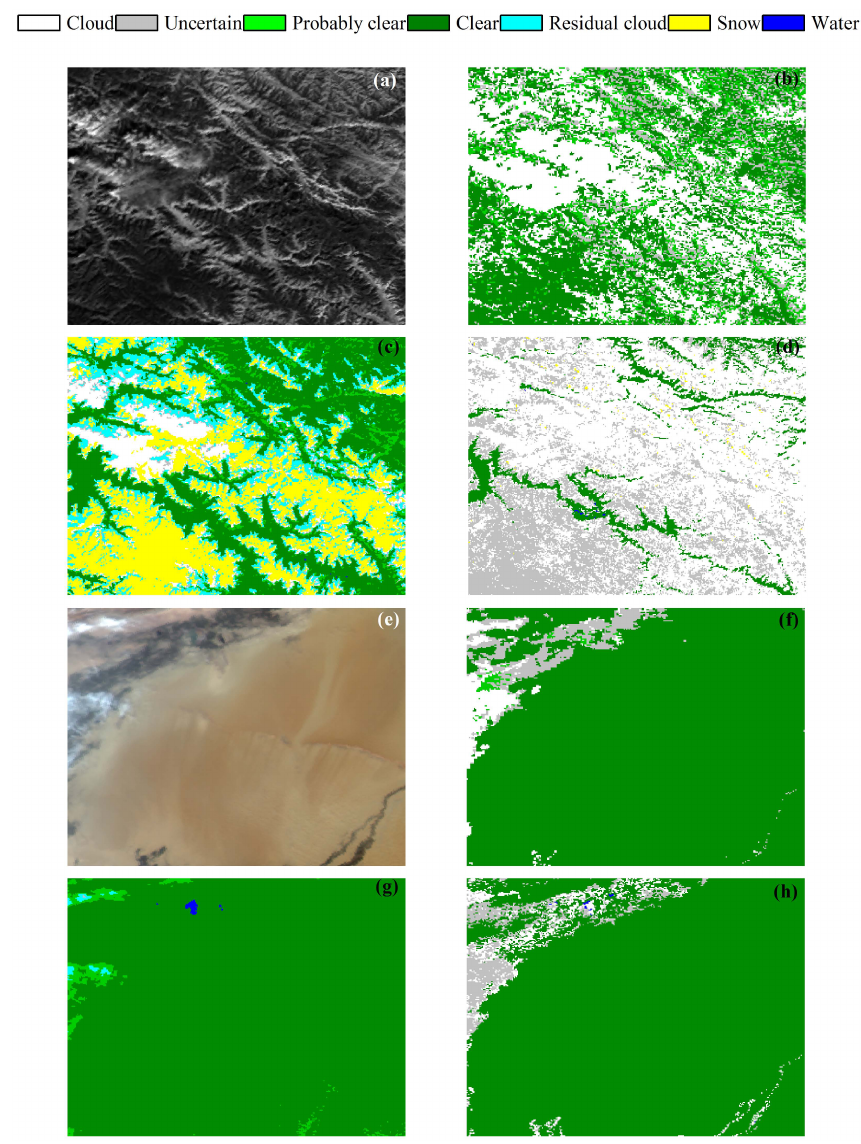
Fig. 8. Two cases during the seasons with poor HR scores compared with MODIS. (a) – (d) The snow-covered case on 12 December 2011 (VIRR at 05:25:00UTC, MODIS at 05:20:00UTC). (a) The VIRR gray-scale image of channel 6 (1.55–1.64µm); (b) – (d) the cloud detection results from MODIS, the proposed algorithm, and the official VIRR product, respectively. (e) – (h) The case over deserts on 24 August 2011 (VIRR at 05:00:00UTC, MODIS at 05:05:00UTC). (e) The true-color VIRR image composed of channel 1 (red), channel 9 (green), and channel 7 (blue); (f) – (h) the cloud detection results from MODIS, the proposed algorithm, and the official VIRR product,